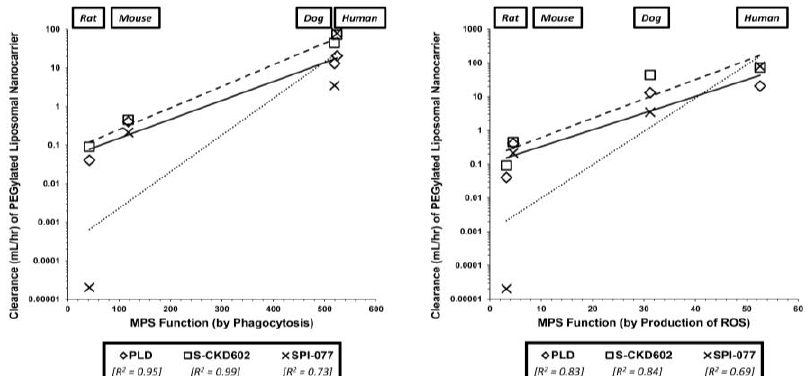
Figure 3. Activity of the MPS (phagocytosis and production of reactive oxygen species [ROS]) in monocytes from blood compared to the clearance of PEGylated liposomal nanocarriers in mice, rats, dogs, and patients. The ability to more accurately convert preclinical data into human patients may best be performed by measuring the factors responsible for NP uptake and clearance, such as the cellular function of the MPS. The mean values for three species are represented by individual symbols, with ♦ as PLD, (cid:3) as S-CKD602, and X as SPI-077. The exponential line of best fit for each group is represented by the lines. Overall, a positive association can be seen between cellular function and clearance of PEGylated liposomal nanocarrier agents. Reproduced with permission from Caron et al. J Pharmacol Exp Ther. 2013, 347, 599 – 606.